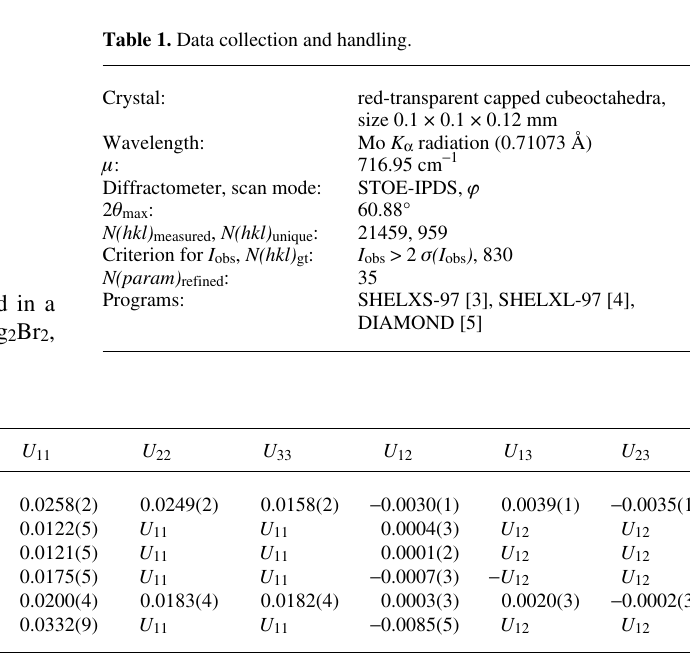
to [Hg 6 Sb 4 ](SbBr 6 )Br [1,2]. Their crystal structures are charac- terized by three-dimensional cationic frameworks based on types of holes of different size filled completely either by octahe- dral (InBr 6 ) 3 − groups or by isolated Br − ions in an ordered way.